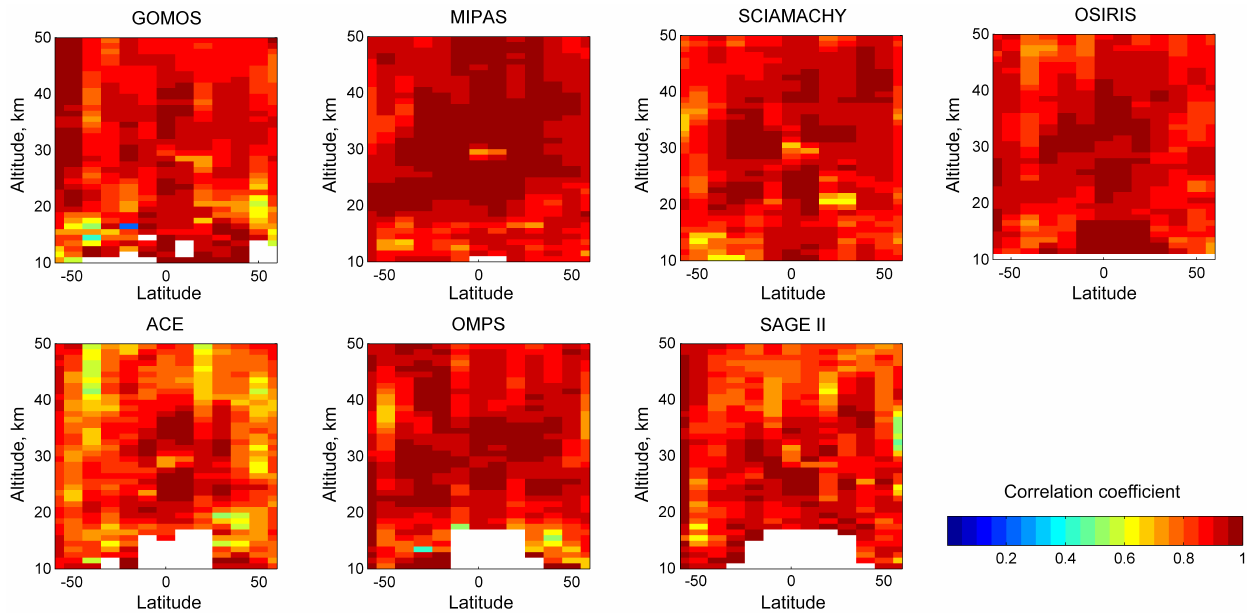
Figure 7. Correlation coefficient between individual and merged deseasonalized anomalies in the period 2001–2016 at latitudes 60 ◦ S–60 ◦ N.